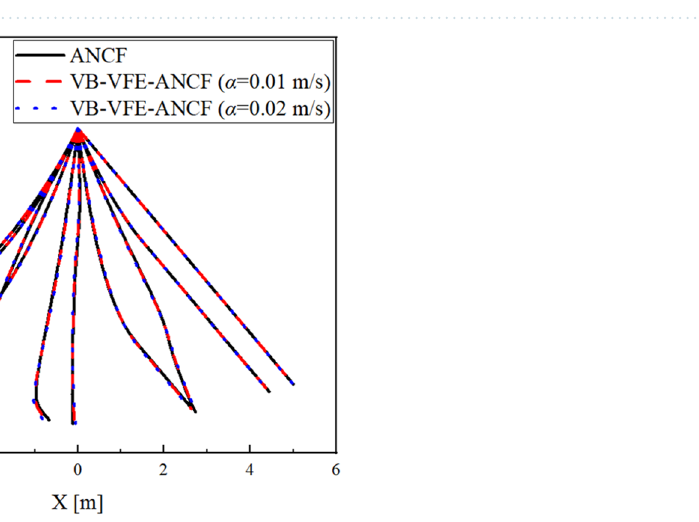
Figure 7. Comparison of X coordinate values of flexible pendulum obtained using ANCF and VB-VFE-ANCF (left), and enlarged view (right). These results are in good agreement. This shows that it is possible to obtain the numerical analysis results with the same accuracy as ANCF by using VB-VFE-ANCF.